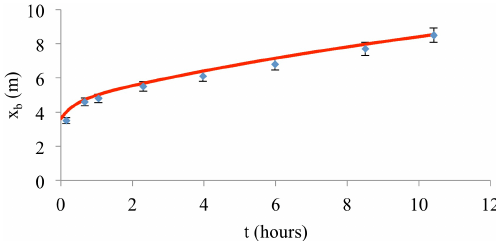
Figure 5. Comparison between measured (diamonds) and predicted (red line) brinkpoint position. Error bars denote ± 5% of the brink- point position.